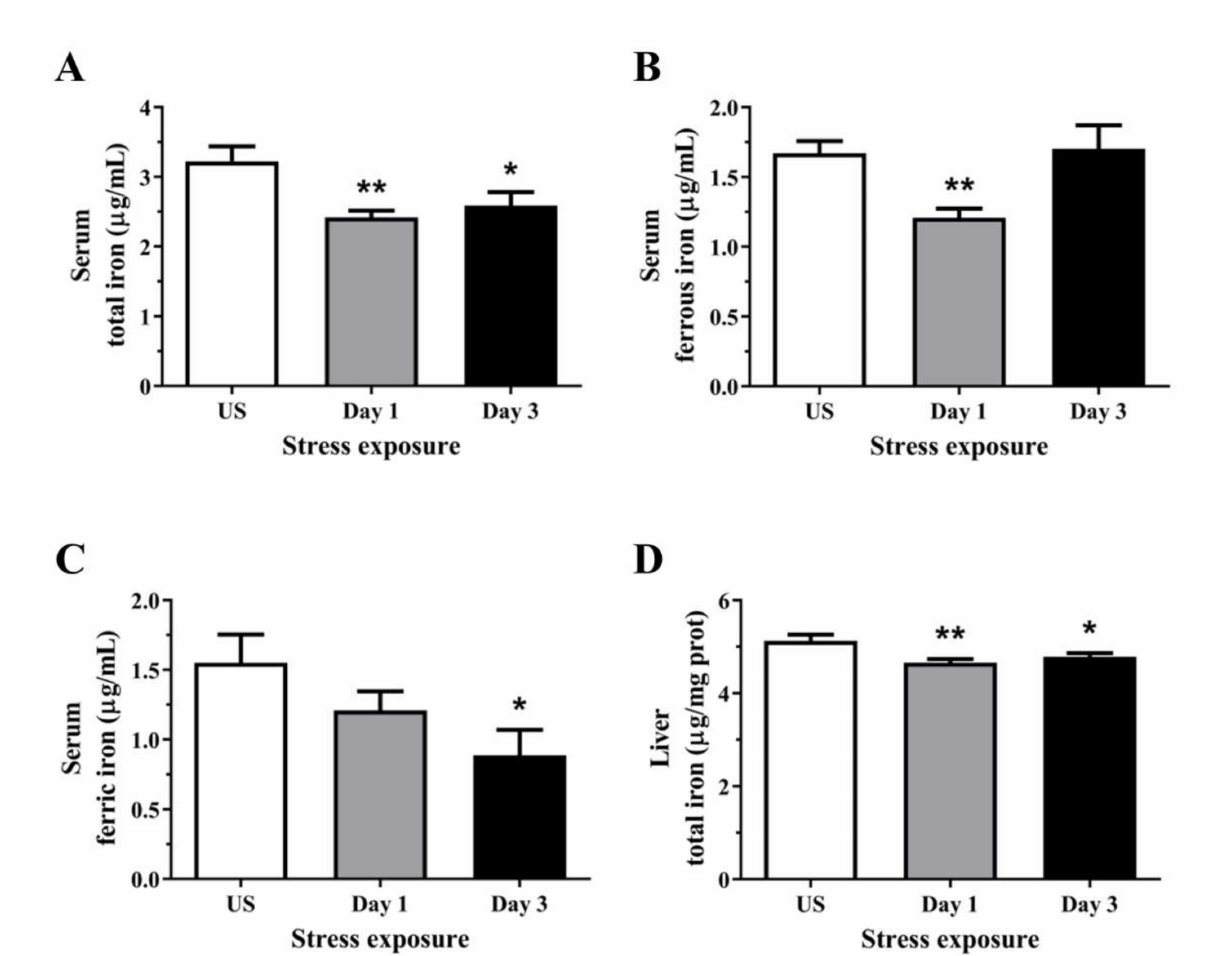
Figure 4. The effects of acute (Day 1, single 6 h) and repeated (Day 3, 6 h/day) restraint stress on ( A ) serum total iron, ( B ) serum ferrous iron, ( C ) serum ferric iron, and ( D ) liver total iron levels compared to unstressed (US) rats ( n = 6–8/group). Results were analysed using one-way ANOVA with Fisher’s LSD test. Data are expressed as mean ± SEM, * p < 0.05, and ** p <